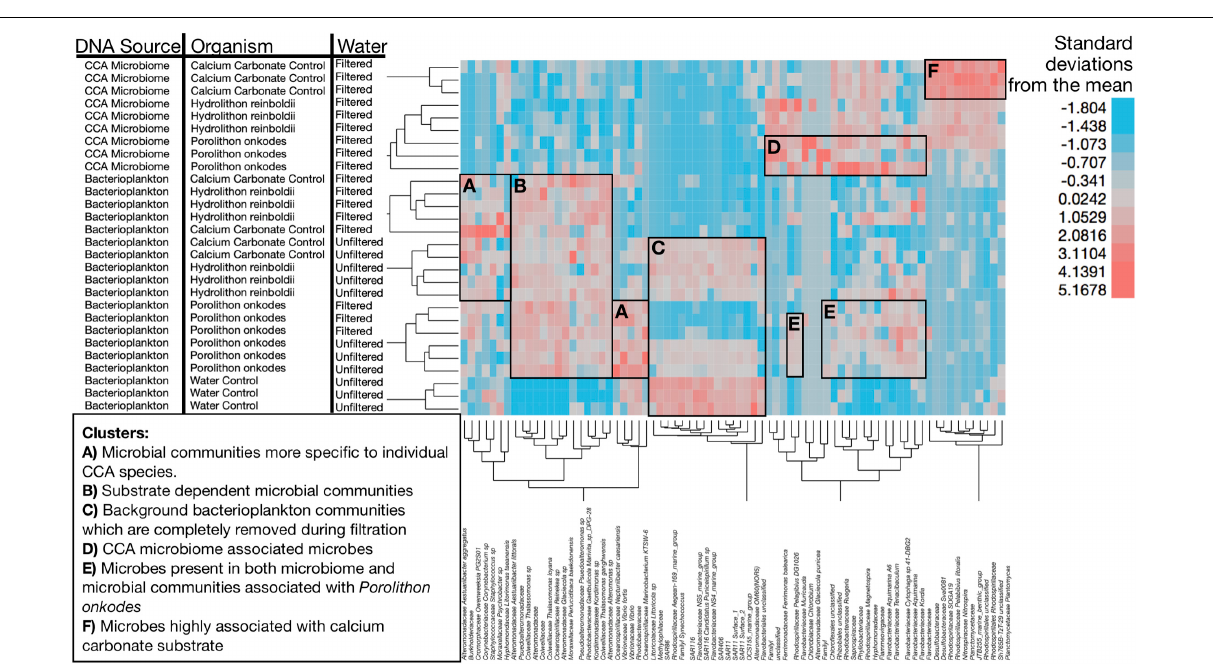
FIGURE 5 | Clustering of microbial community samples by OTU. Each row is a sample and annotated to denote DNA source, water treatment and organismal treatment. Regions highlighted to show specific associations of bacteria to specific clusters of samples. Width of rectangles guided by cluster dendrogram to highlight clusters of samples with similar experimental characteristics. Height of the highlighting was selected to illustrate the organisms whose relative abundances were most enriched in those sample clusters. (A) Microbial communities more specific to individual CCA species. (B) Substrate dependent microbial communities. (C) Background bacterioplankton communities which are completely removed during filtration. (D) CCA microbiome associated microbes (boxed around Porolithon onkodes). (E) Microbes present in both microbiome and microbial communities associated with Porolithon onkodes, suggesting sloughing from CCA microbiome. (F) Microbes highly associated with calcium carbonate substrate. Heat map illustrates standardized relative abundance of OTUs in units of standard deviation. Dendrogram was generated using Ward’s minimum variance method to hierarchically cluster samples by OTU relative abundance, square root then arcsine transforming, deriving means, standard deviations and standardizing using z-scores. We used Wards’ minimum variance hierarchical clustering with input data standardized to units of standard deviation using z-scores [(x- µ ) ∗ SD(x) − 1 ] to visualize patterns of association among samples and taxa. For clearer visualization, hierarchical clustering was conducted only on clades which had a minimum relative abundance of 10% in at least one sample ( n = 75 distinct